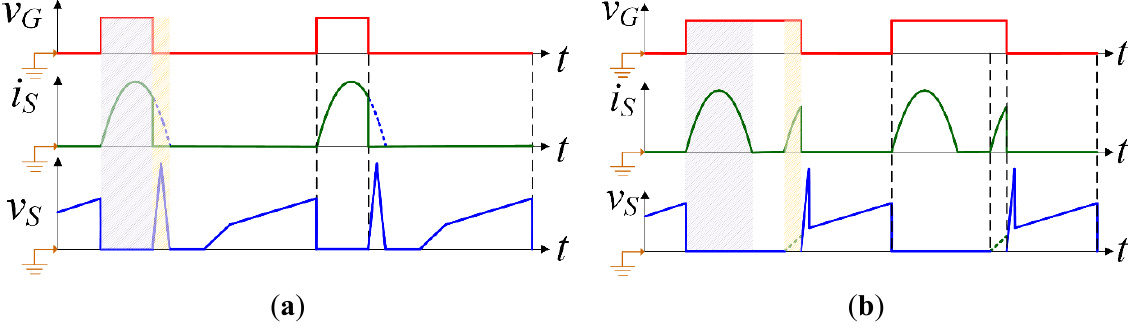
Figure 9. Theoretical waveforms with mismatch driving signal. ( a ) T on is too short